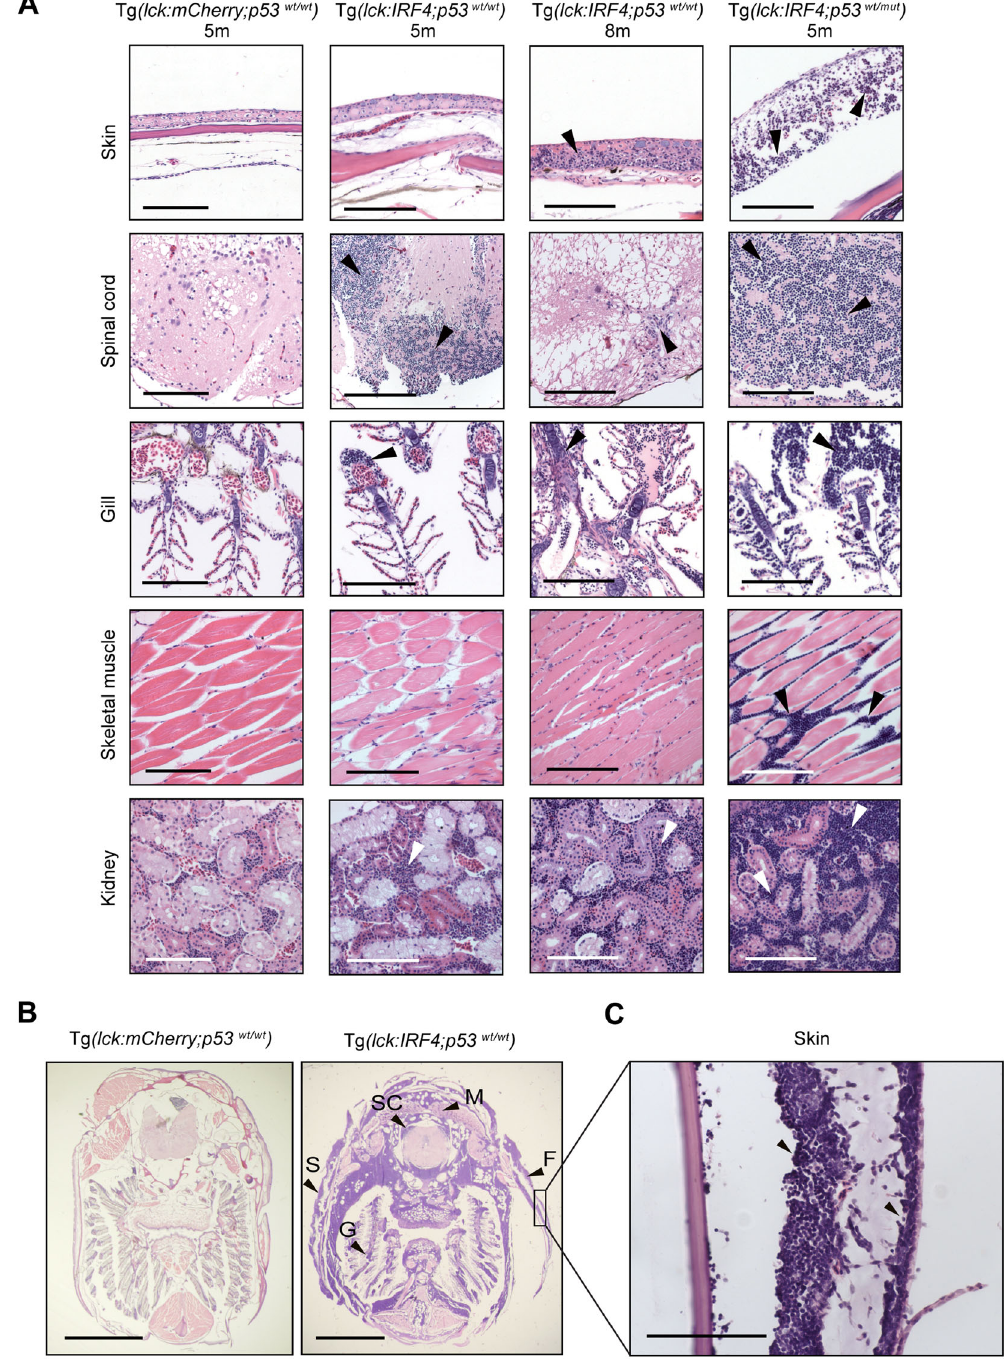
Fig. 2 IRF4 -driven zebra fi sh tumors recapitulate invasive human T-cell lymphoma. A Histopathological examination of H&E-stained tissue sections of representative samples from control Tg( lck:mCherry;p53 wt/wt ) ( n = 8), Tg( lck:IRF4;p53 wt/wt ) ( n = 8) and Tg( lck:IRF4;p53 wt/mut ) ( n = 4) zebra fi sh at 5 or 8 months. Similar fi ndings were observed in multiple independent animals as shown for each sample. Tumor cells are indicated by white or black arrowheads. Scale bar = 100 μ m. B Transverse sections of representative samples from Tg( lck:mCherry;p53 wt/wt ) ( n = 8) and Tg( lck:IRF4;p53 wt/wt ) ( n = 8). F, fi n; G, gill; M, muscle; S, skin; and SC, spinal cord. Similar fi ndings were observed in multiple independent animals as shown for each sample. Scale bar = 2 mm. C High magni fi cation of skin lesions from Tg( lck:IRF4;p53 wt/wt ) fi sh. Scale bar = 100 μ